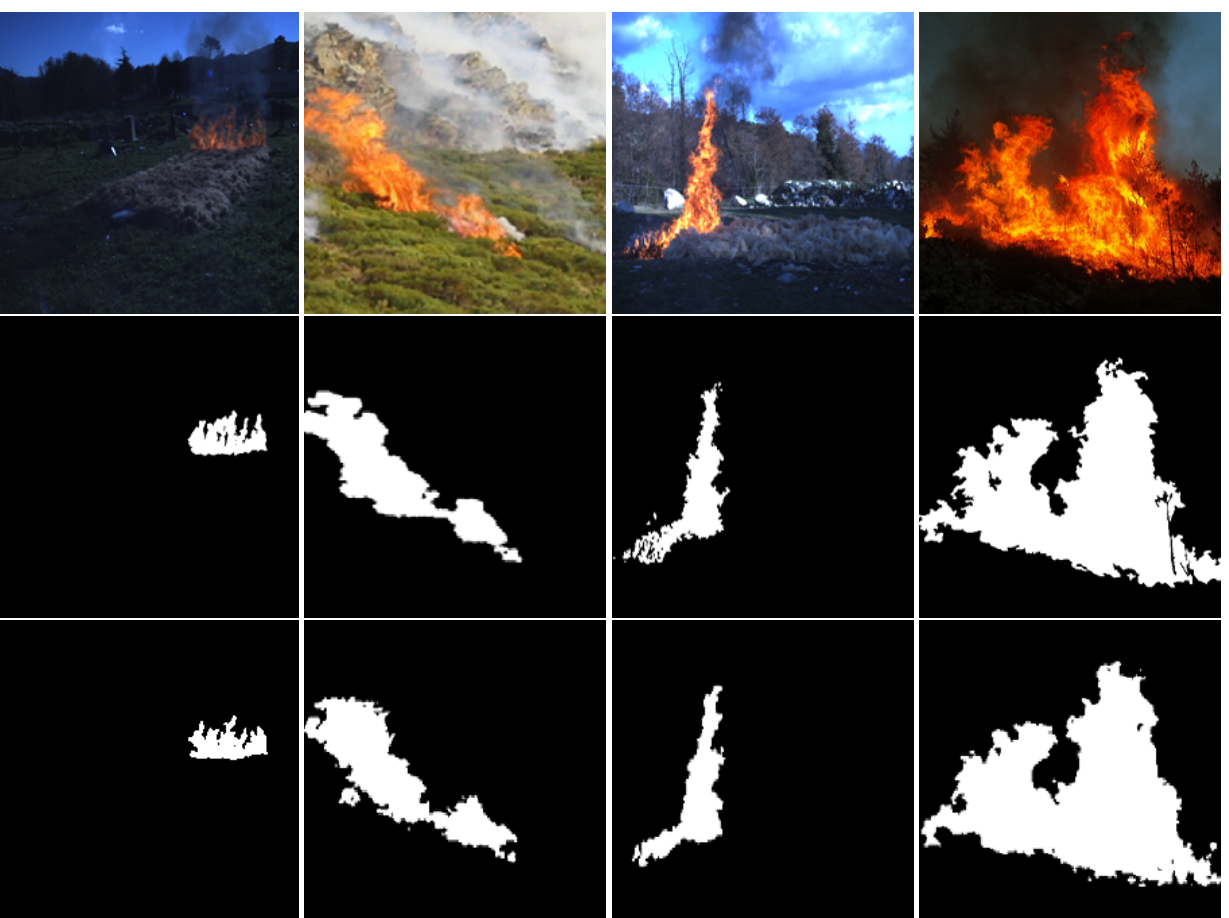
Figure 6. Results of TransUNet-Res50-ViT. From ( top ) to ( bottom ): RGB images, their corresponding mask, and the predicted images of